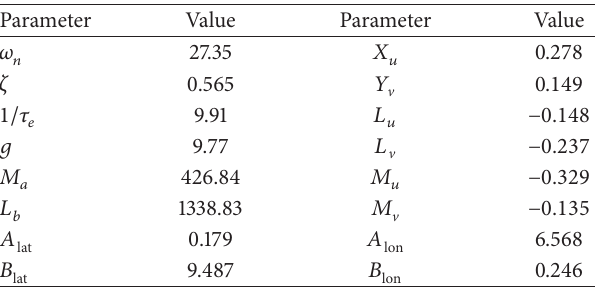
Table 1: The result of